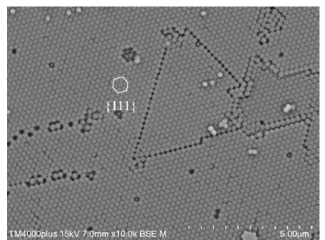
Figure 4. Scanning electron microscopic (SEM) image of P(St-MMA-AA) colloidal crystal coating assembled from spheres of 230 nm diameters.